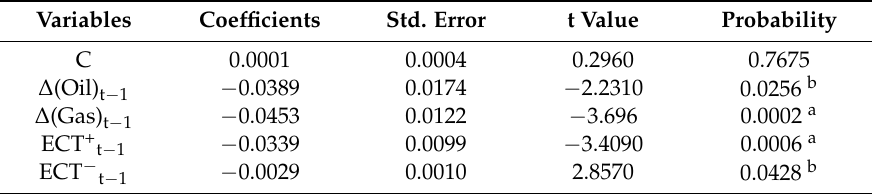
Table 3. Asymmetric Price Transmission-ECM (Error Correction Model), or Oil to Gas Transmission- Dependent ∆